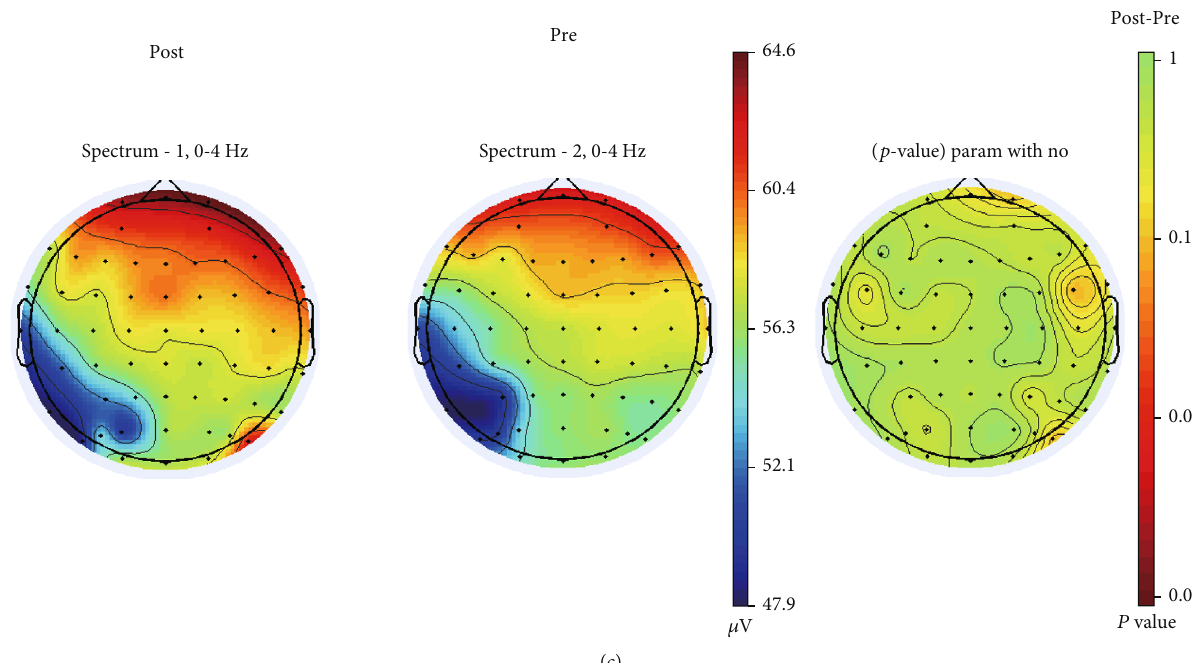
Figure 2: Power spectrum topographic map of the alpha, gamma, and delta bands. Power spectrum topographic map of the alpha band (a). Power spectrum topographic map of the gamma band (b) (Post: after NFB treatment, Pre: before NFB treatment, Post-Pre: Post minus Pre). Power spectrum topographic map of the delta band